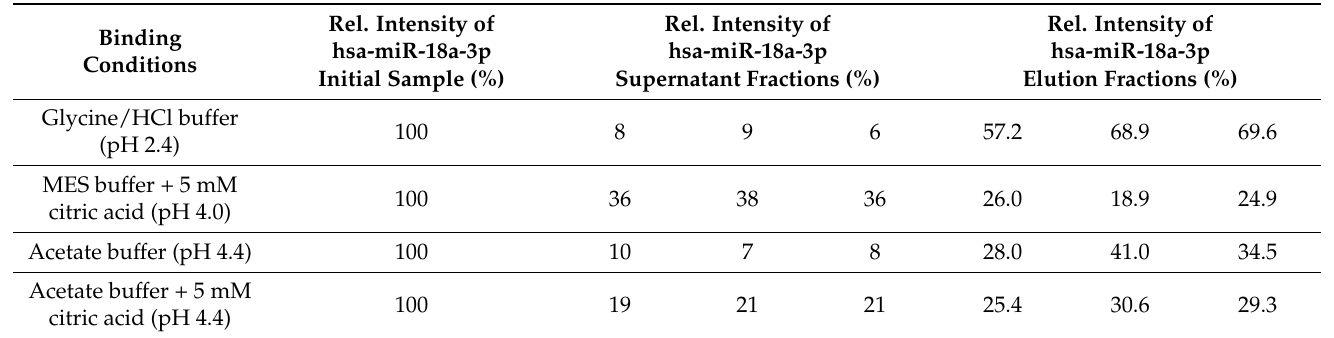
Table 1. The relative yields of hsa-miR-18a-3p in fractions obtained during the isolation protocol using model RNA mixture in different binding